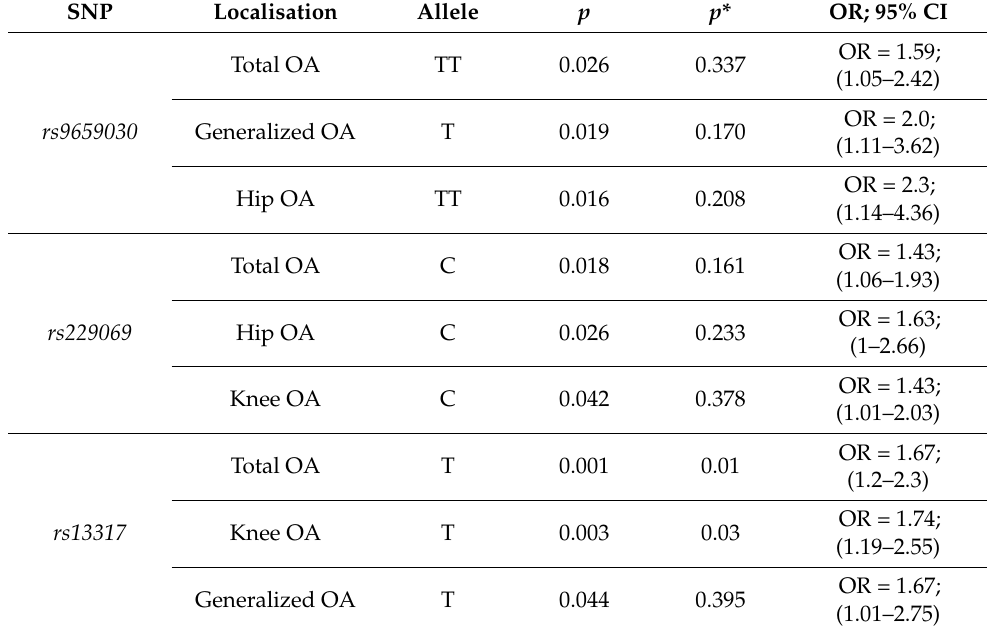
Table 3. Associations of the miRNA target sites loci in different OA localization subgroups.